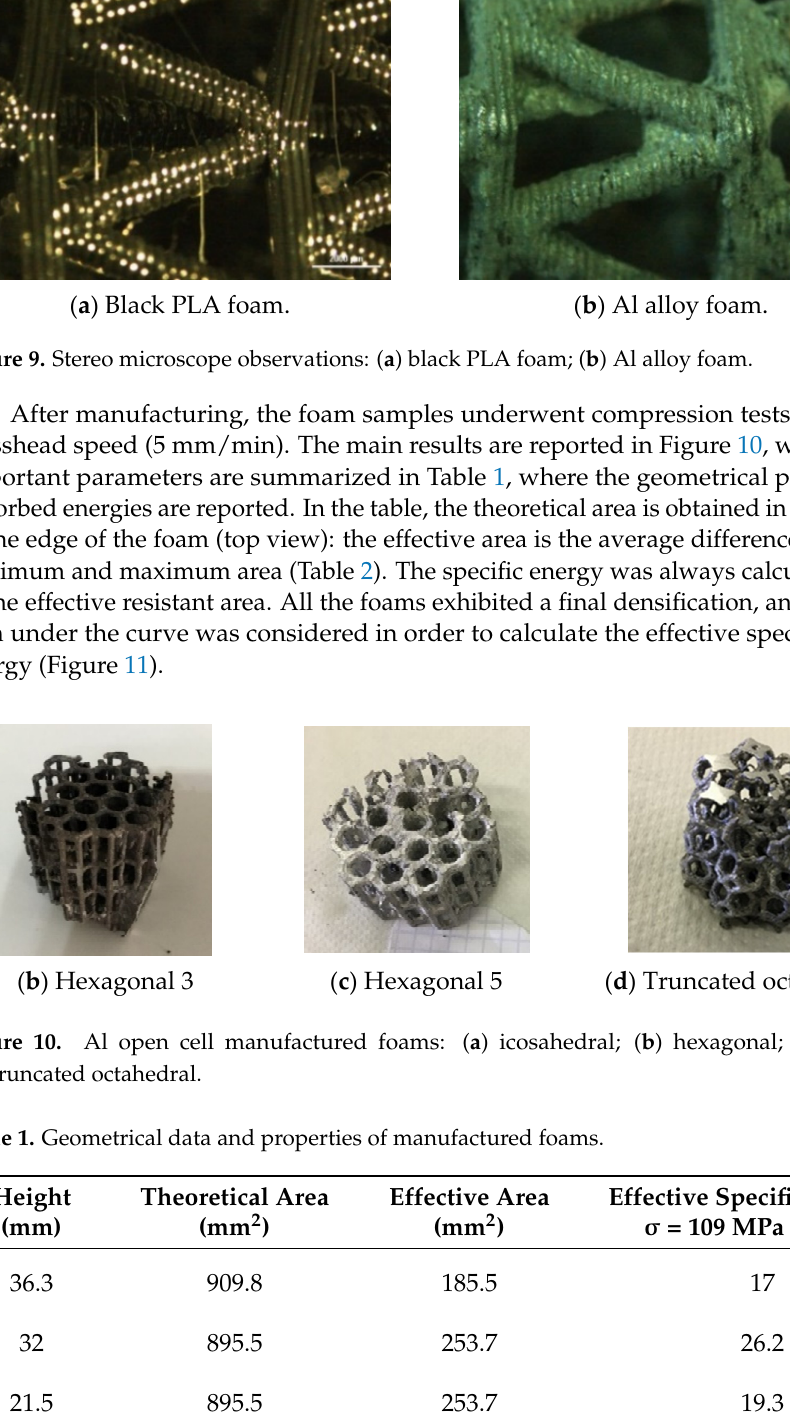
Figure 8. Main defects in Al alloy open foam. ( a ) Al infiltration; ( b ) cells not completed; ( c ) infiltration of Al in the vents; ( d , e ) porosity of hexagonal cell foam; ( f ) layer evidenced in truncated octahedron elementary cell Al alloy foam.